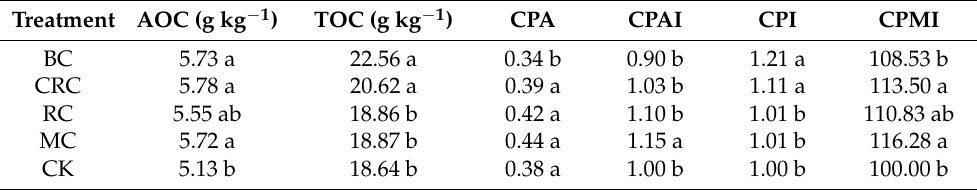
Table 6. Soil carbon pools under different organic material treatments in